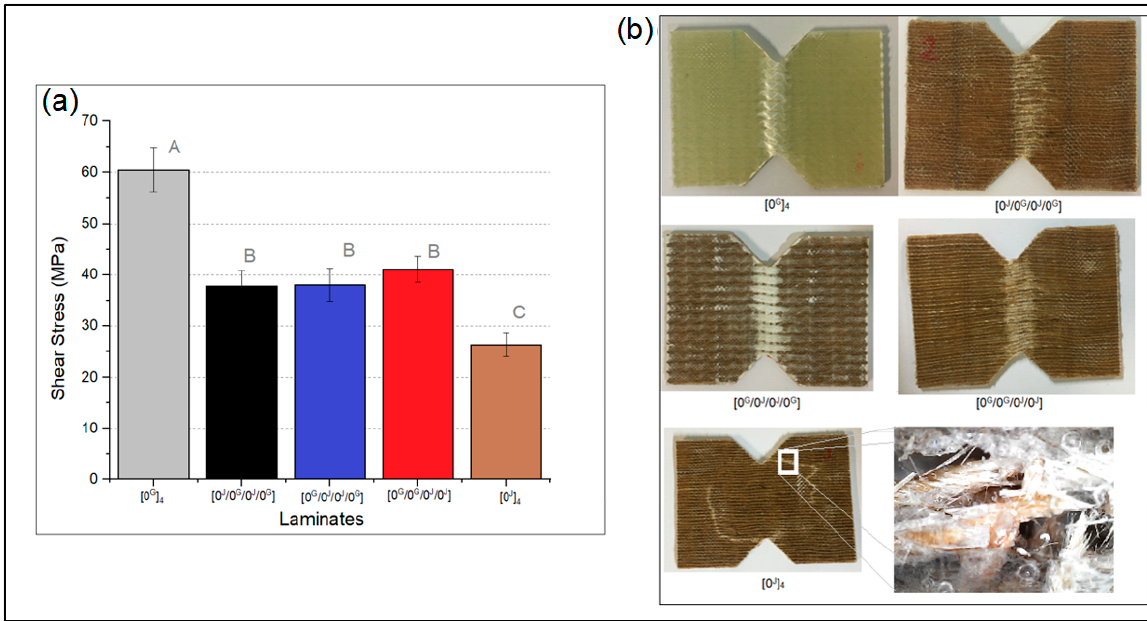
Figure 9. ( a ) Mean shear strength of the laminates, and ( b ) images of the specimens after testing (letters represent the results of the Tukey’s test).